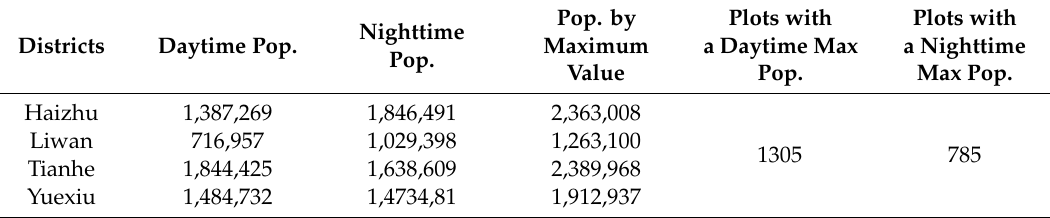
Table 2. Statistics of daytime and nighttime population (pop.) of districts and plots. Districts Daytime Pop.